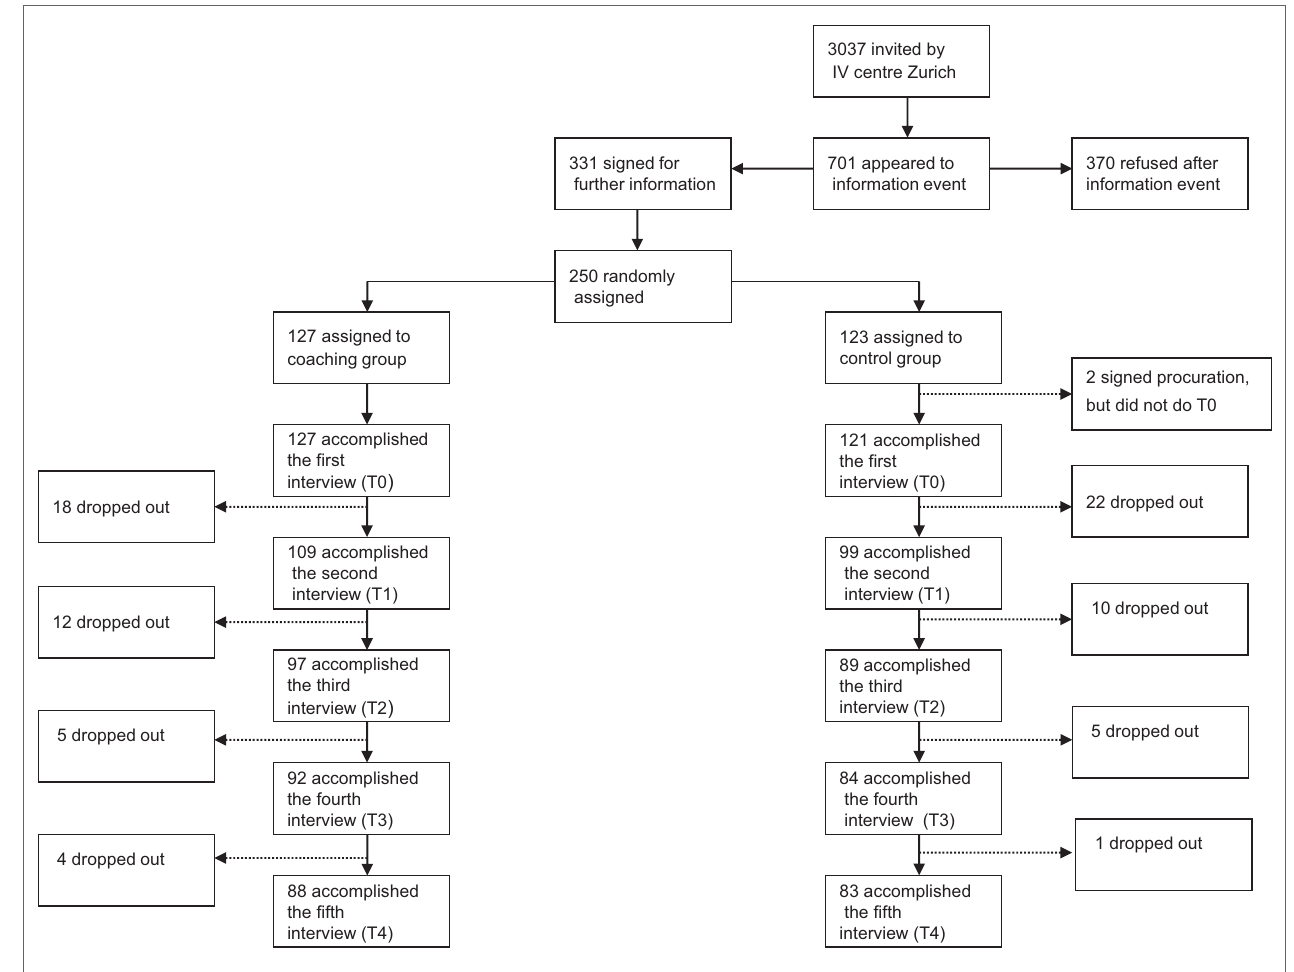
FigUre 1 | Flow chart of recruitment process